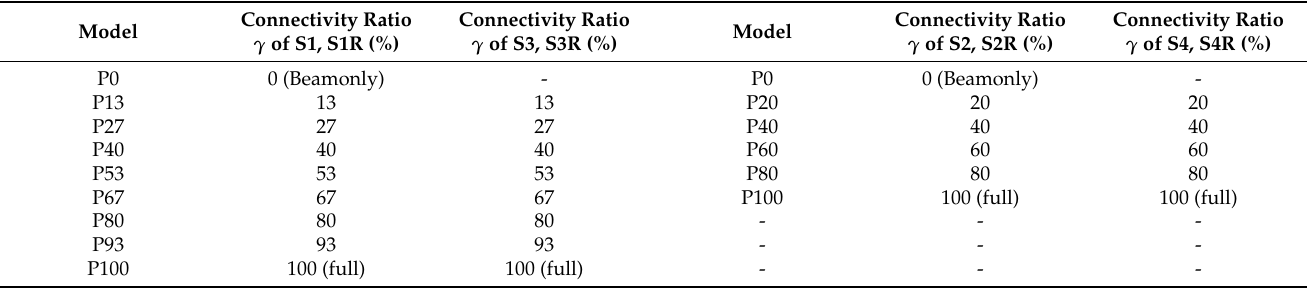
Table 2. Models with different connectivity